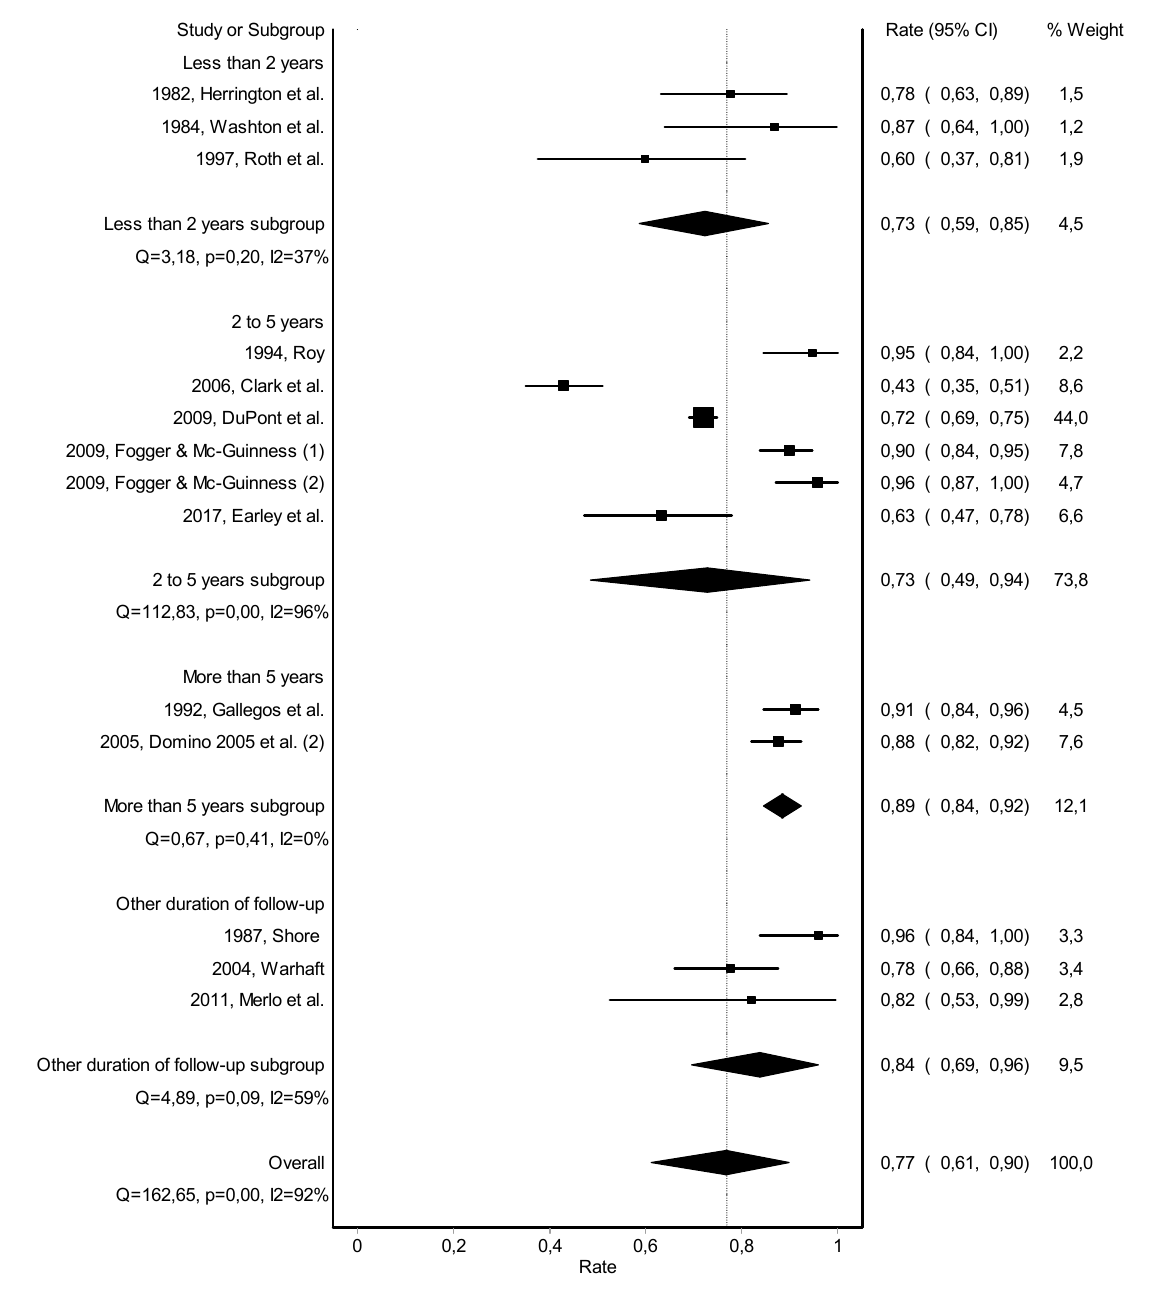
Figure A8. Forest plot of the pooled work retention rate—subgroup analysis based on duration of follow-up.